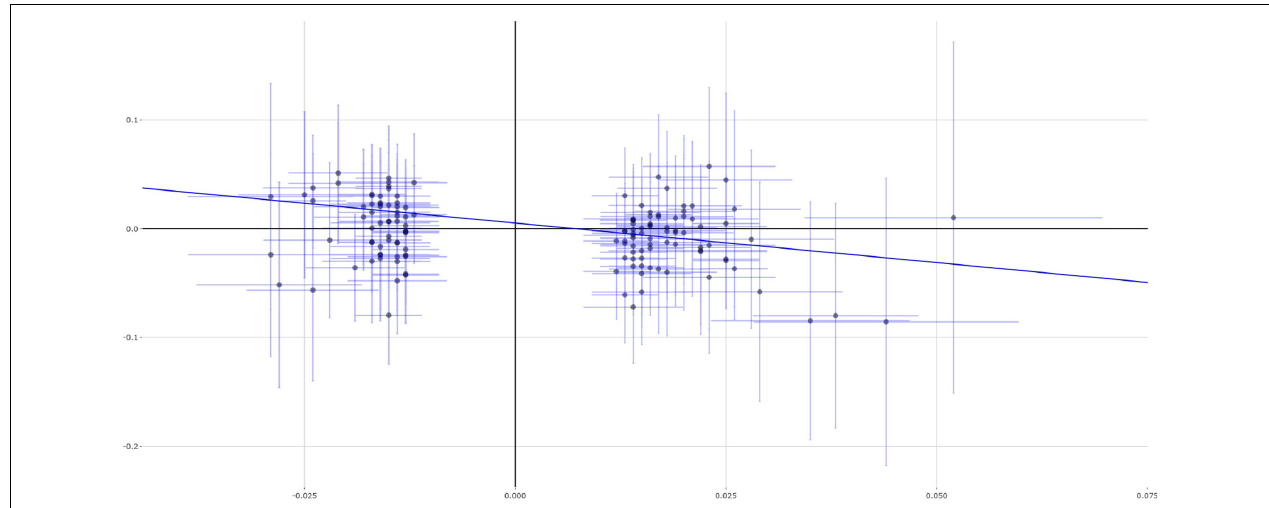
FIGURE 3 | Single estimates about causal association between educational attainment and asthma from MR analysis using MR-Egger method. This scatter plots represent 141 genetic variants associated with educational attainment on x -axis and risk of asthma on y -axis. Continuous line represents causal effect of educational attainment on risk of